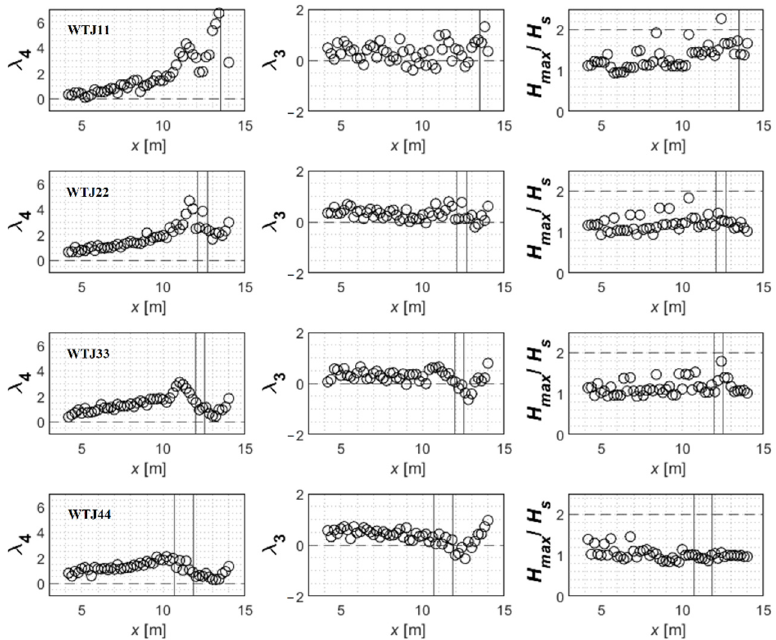
Figure 6. The spatial evolution of λ 4 , λ 3 and H max / H s for the four studied JONSWAP ( γ = 7) wave trains.